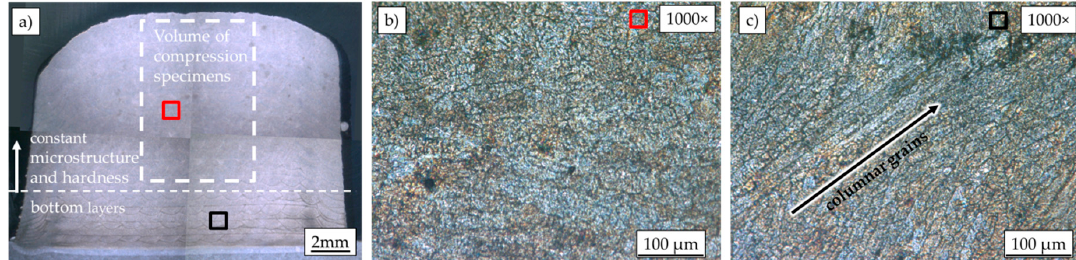
Figure 14. Microscope images of etched cross sections after annealing for a sample made out of H11 powder containing 0.2 wt. % nanoparticle additives: ( a ) complete cross section, ( b ) in the region of homogenous microstructure and constant hardness (1000×) and ( c ) in the softer lower region (1000×) (etching method: V2A).